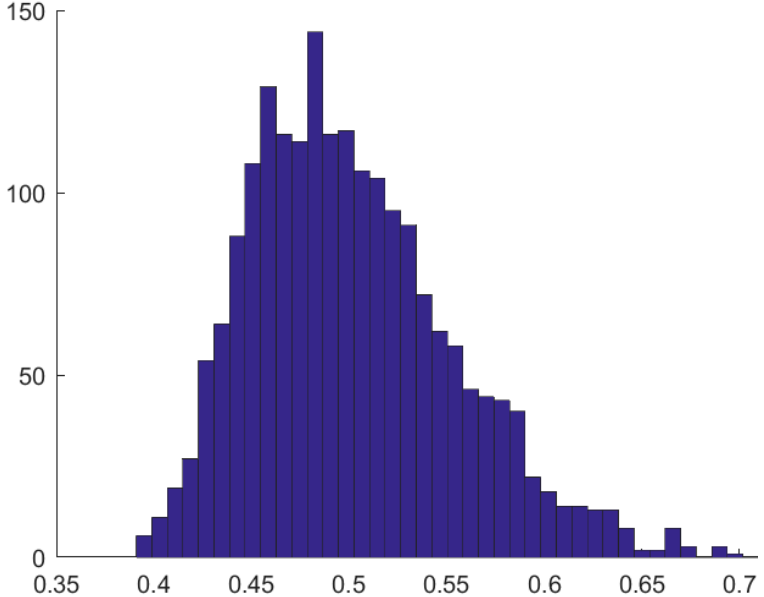
Figure 9. Statistical distribution chart of zero oil leakage rate.